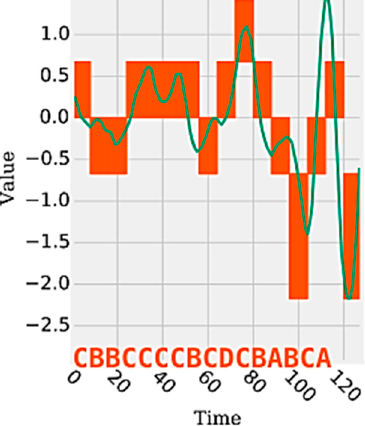
Figure 1. Example of a discretized time series [29].